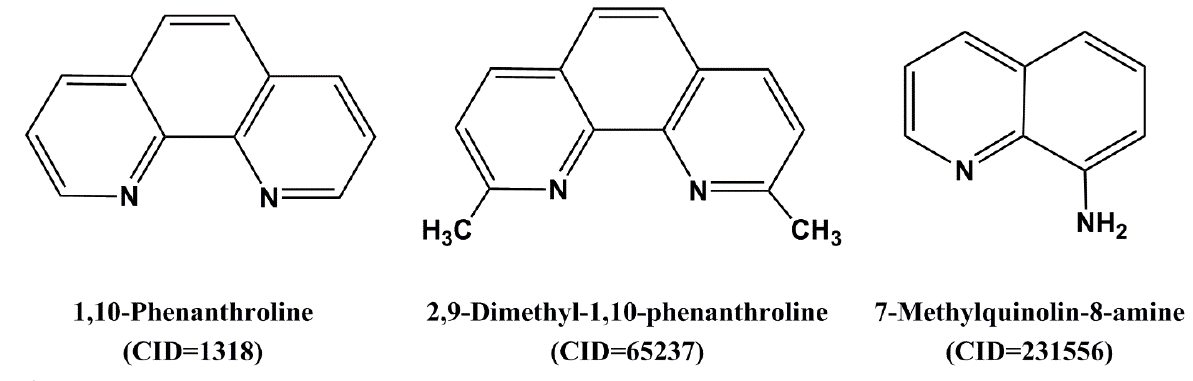
Figure 5. Chemical structure of compounds used to validate the SVM